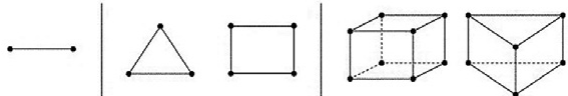
Fig. 11. Finite elements: beam (left), shell (middle), brick (right)